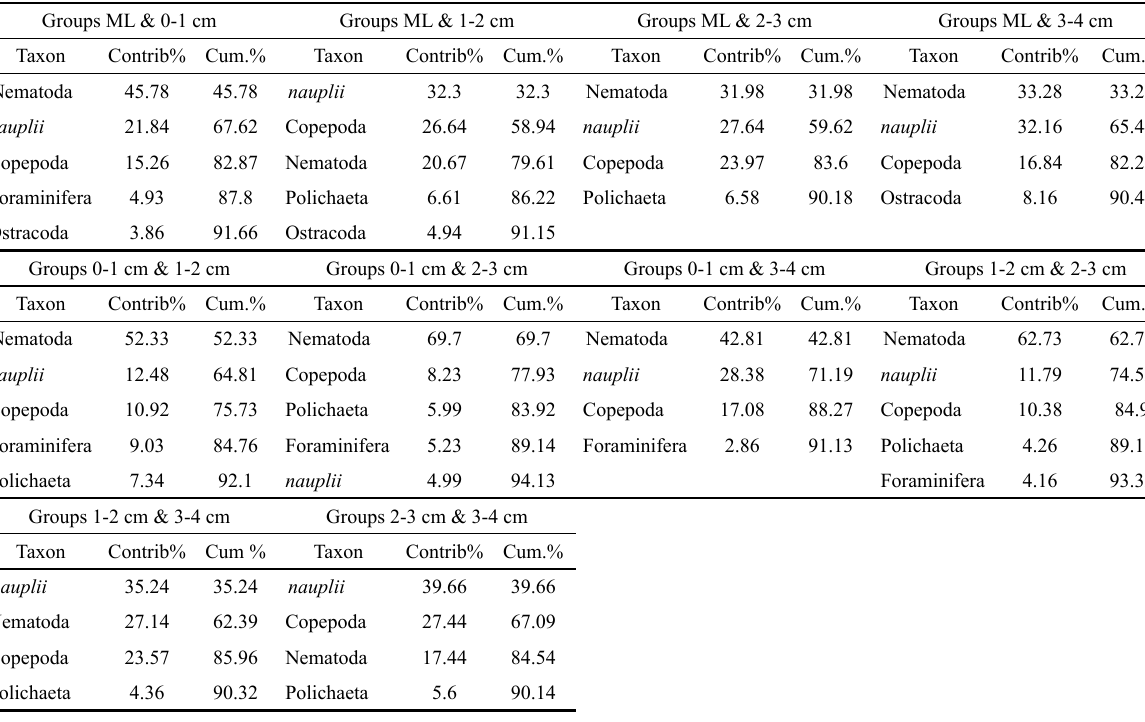
Table S2. – SIMPER analysis showing the contribution of meiofaunal taxa to between-layer dissimilarity. Contrib.%, contribution %; Cum.%,